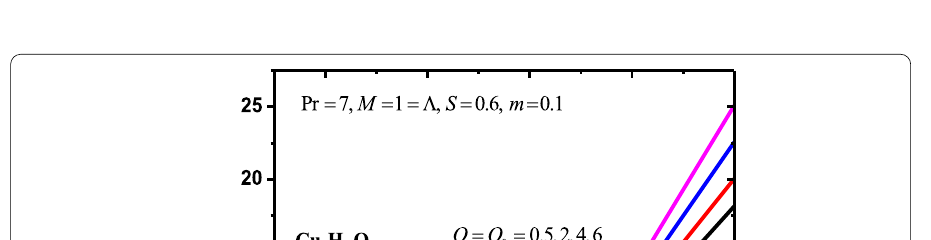
θ ′ ( 0 ) due to Re and Q −